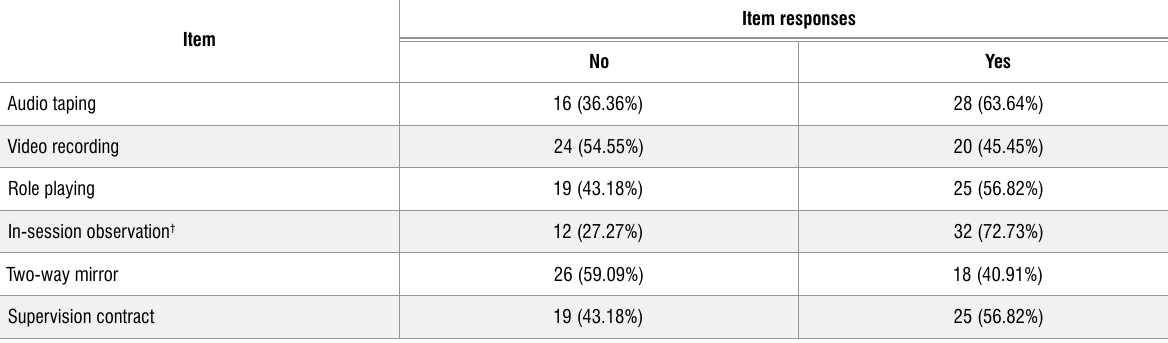
Table 4: Frequency statistics ( n (%)) for supervision training technique items